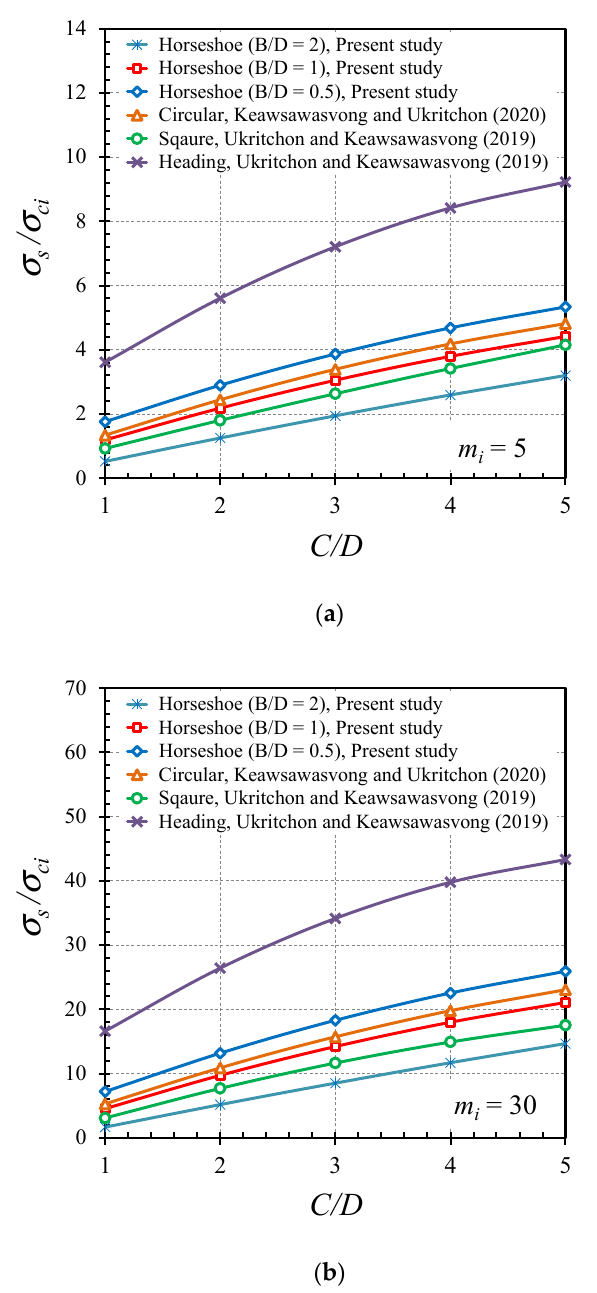
Figure 16. Comparison of the stability factors σ s / σ ci for different shapes of tunnels: ( a ) m i = 5 and ( b ) m i = 30 ( σ ci / γ D = 1000 and GSI = 80 Design equations.